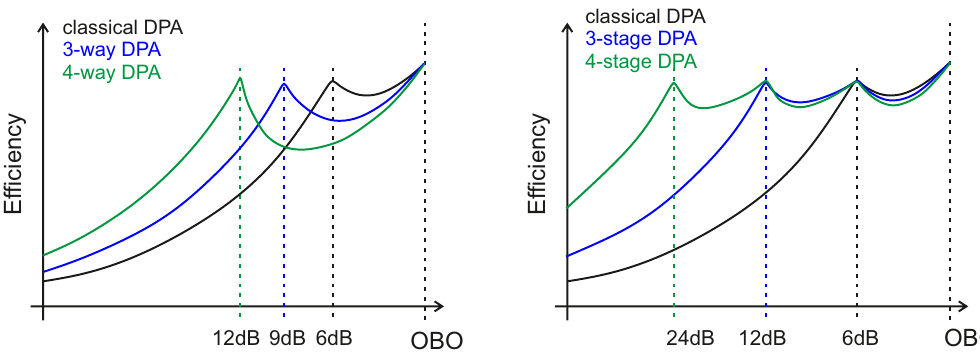
Figure 7. Multi-way and multi-stage DPA